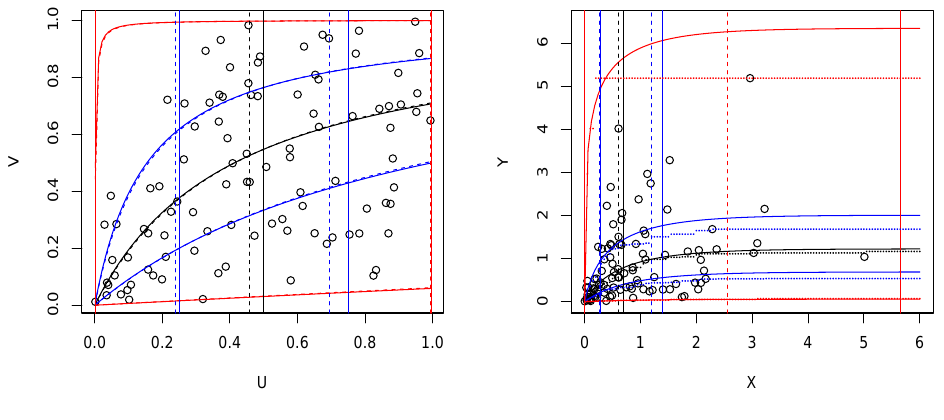
Figure 12: BBP in option 1. b for the data in Example 2.2 when we use a parametric estimation for the Clayton copula based on the Kendall’s tau coefficient. The dashed lines represent the estimations and the continuous lines the theoretical